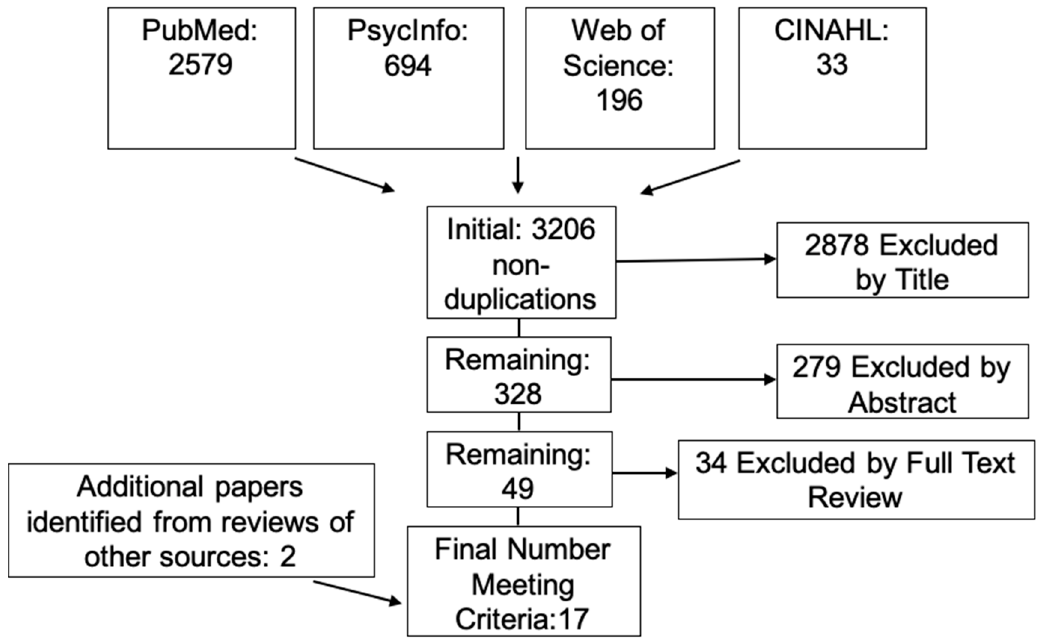
Figure 1. A total of 17 articles meeting the inclusion criteria were identified.